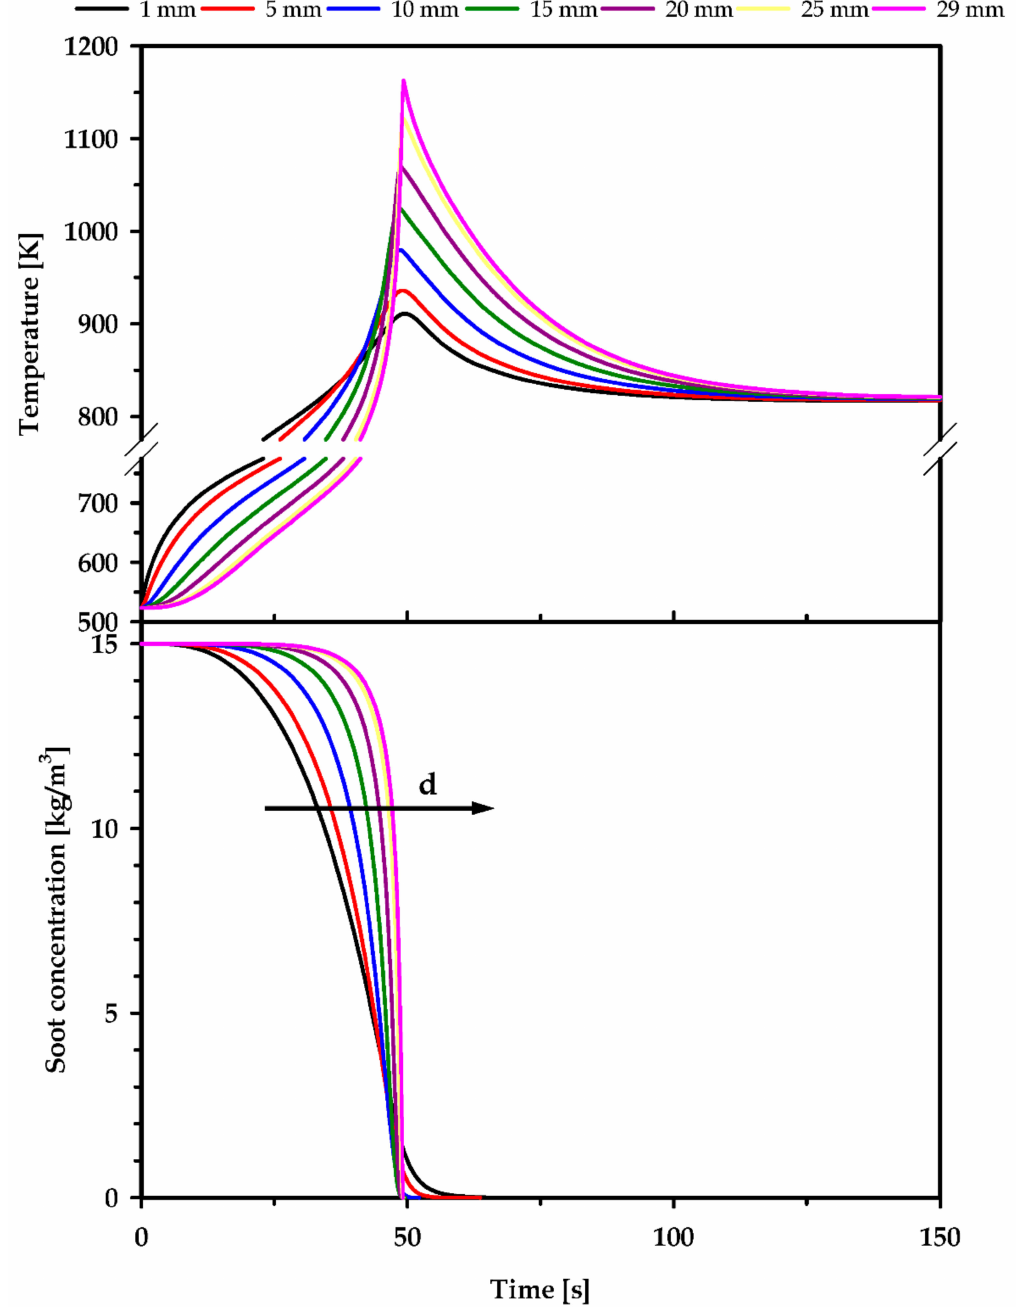
Figure 5. Time histories of temperature and soot concentration (monitor points of Figure 2): k = 10. The arrow indicates the direction of propagation of the reaction front: d = downstream propagation (from upstream—1 mm-to downstream—29